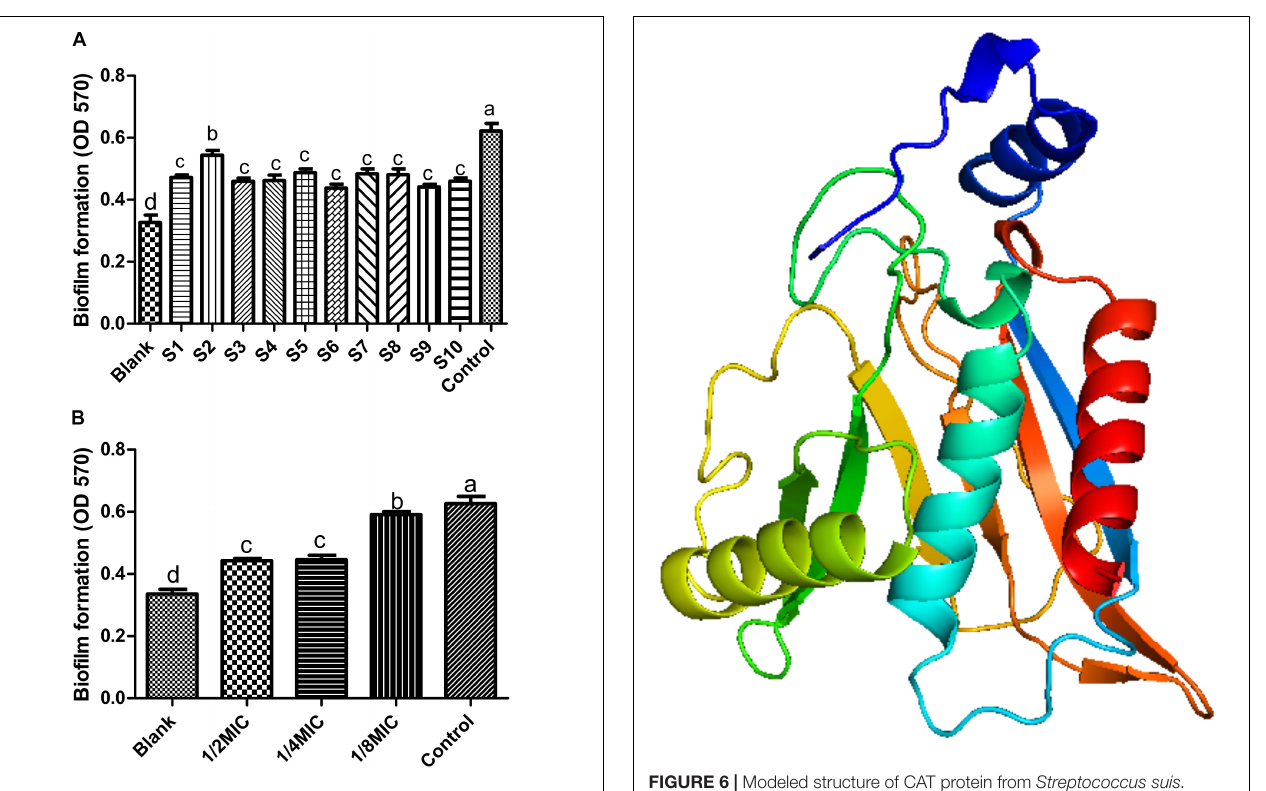
FIGURE 5 | Inhibitory effect on biofilm formation by Streptococcus suis ( n = 5, x ± SD): (A) 10 batches of S. oblata samples; (B) the rutin standard. Different letters indicate a significant difference at p < 0.05.